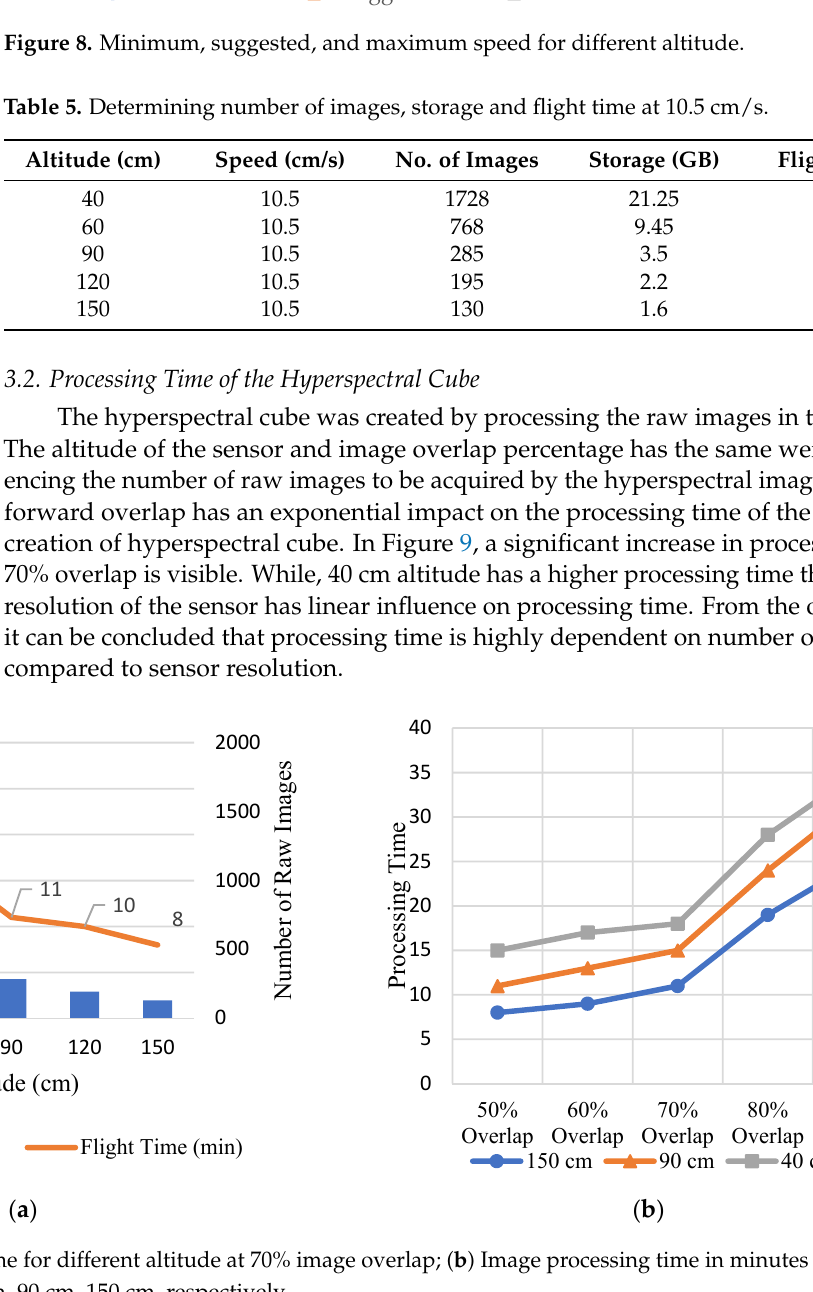
Table 4. Altitude and suggested speed for sensors altitude.